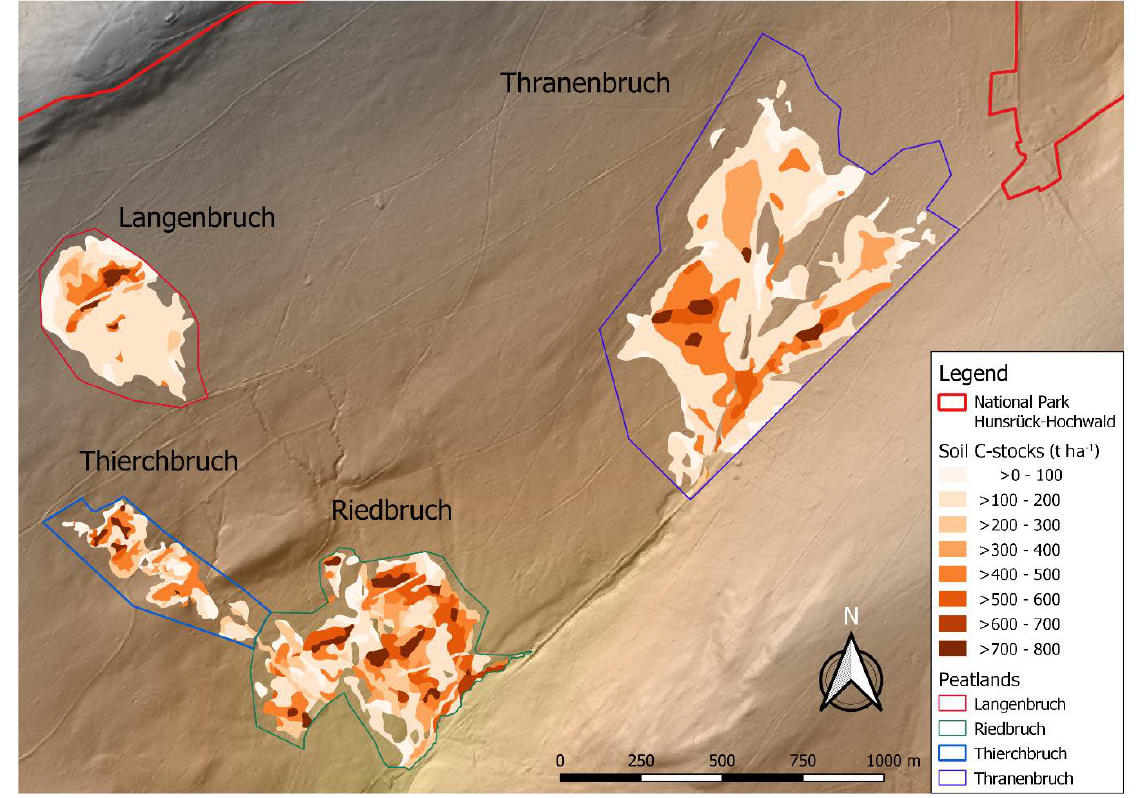
Figure 5. Distribution of soil carbon stocks at monitoring